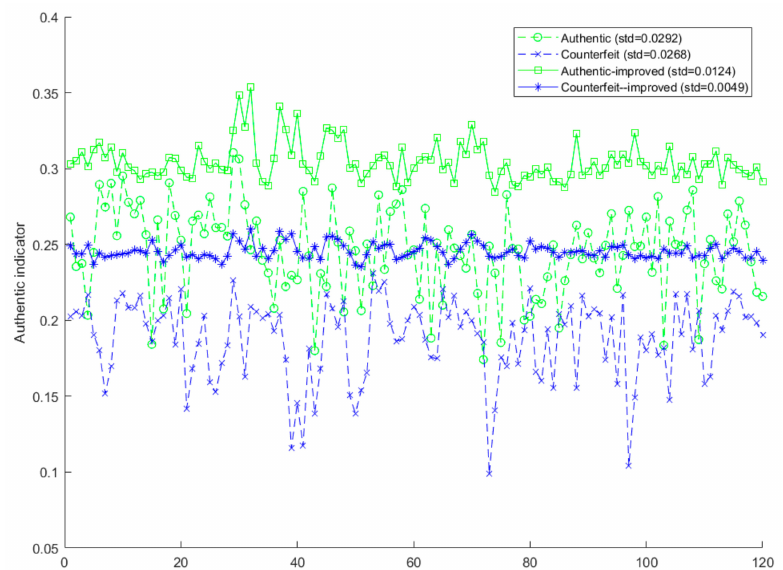
Figure 10. Authenticity indicators for authentic and counterfeit 2LQR code tag images scanned with HP LaserJet Pro M126 MFP. The plus sign and square are authenticity indicators for authentic and counterfeit 2LQR code tag images without the improved algorithm, respectively. The circle and asterisk are authenticity indicators for authentic and counterfeit 2LQR code tag images with the improved algorithm,